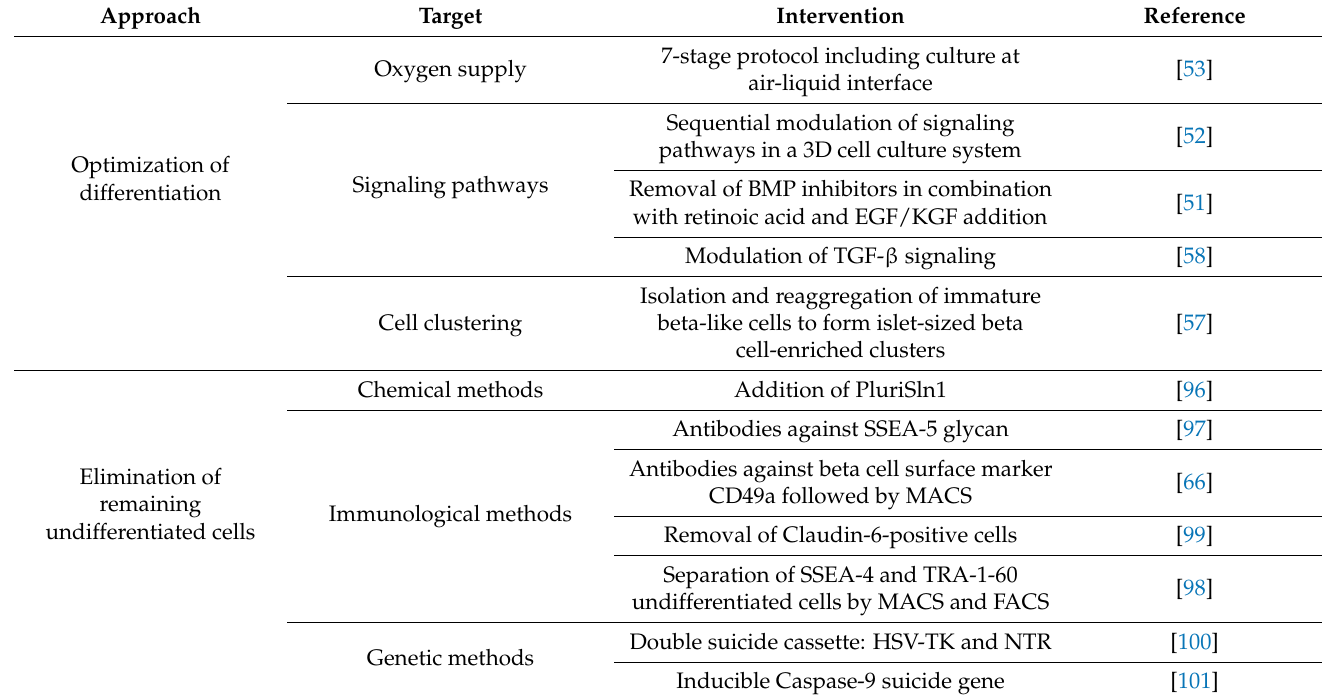
BMP: bone morphogenetic proteins, EGF: epidermal growth factor, FACS: fluorescence-activated cell sorting, HSV-TK: herpes simplex virus thymidine kinase, KGF: keratinocyte growth factor, MACS: magnetic-activated cell sorting, NTR: nitroreductase, PluriSln1: pluripotent cell-specific inhibitors, SSEA: stage-specific embryonic antigen, TGF- β : transforming growth factor β